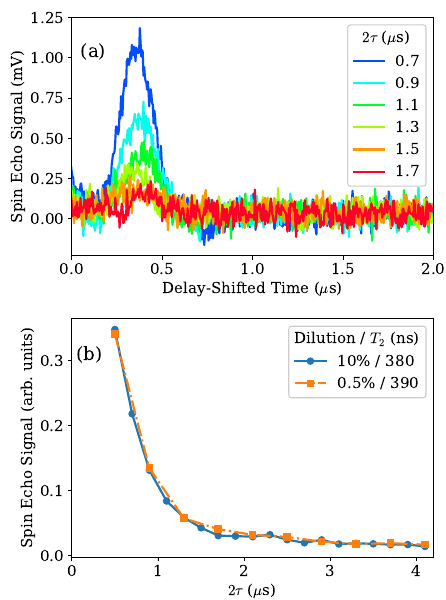
Figure 4. ( a ) background-subtracted spin echo signal at various delay times 2 τ , at 4.43 GHz and 20 Oe. The time axis has been shifted such that every echo occurs at the same effective time; ( b ) spin echo signal area as a function of the delay time 2 τ for 10% (blue circles) and 0.5% (orange squares) samples. The lines connecting datapoints are guides to the eye.